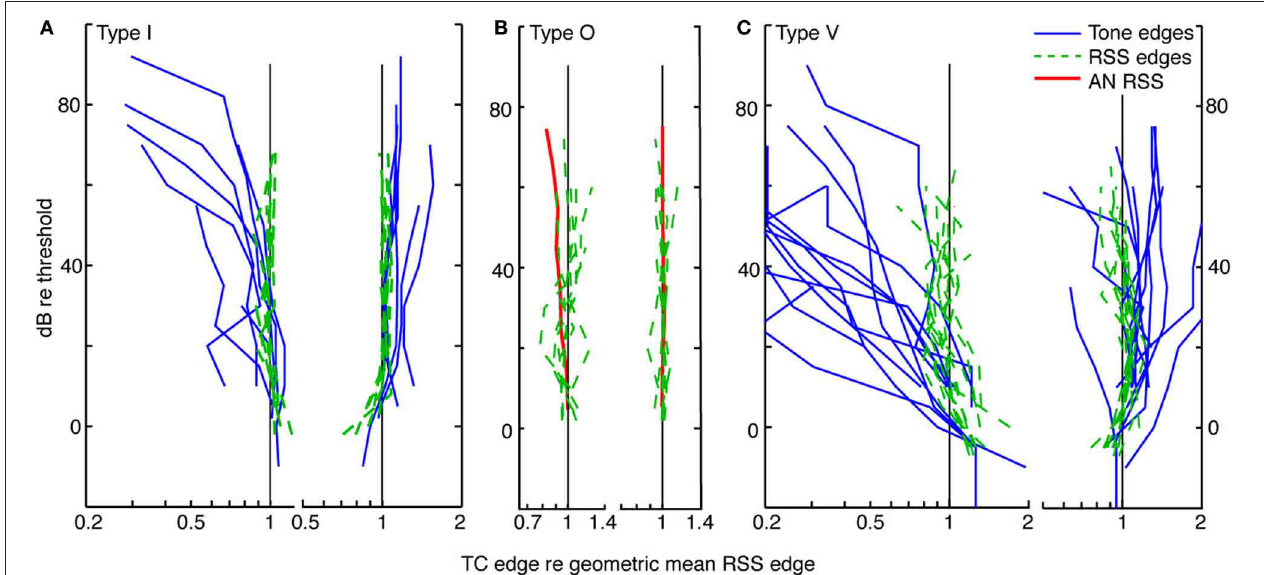
FIGURE 6 | Level tolerance of the edges of tone and weight-function response maps for populations of type I (A), O (B), and V (C) neurons. Frequency edges computed as in Figure 5 are shown for contralateral stimuli only. Lower-(left) and upper-(right) frequency edges derived from tone response maps (blue lines) are overlaid on those derived from weight-function maps (dashed green lines) at equivalent sound levels, in dB re threshold. The point at BF is not included. For each neuron, lower (or upper) edge frequencies are plotted relative to the geometric mean across levels of the lower (or upper) edge frequencies of the weight-function maps. Slopes of lower frequency edges of tone maps differ significantly from those observed in weight-function maps (type I: P = 0 . 1; type V: P < 0 . 01; signed